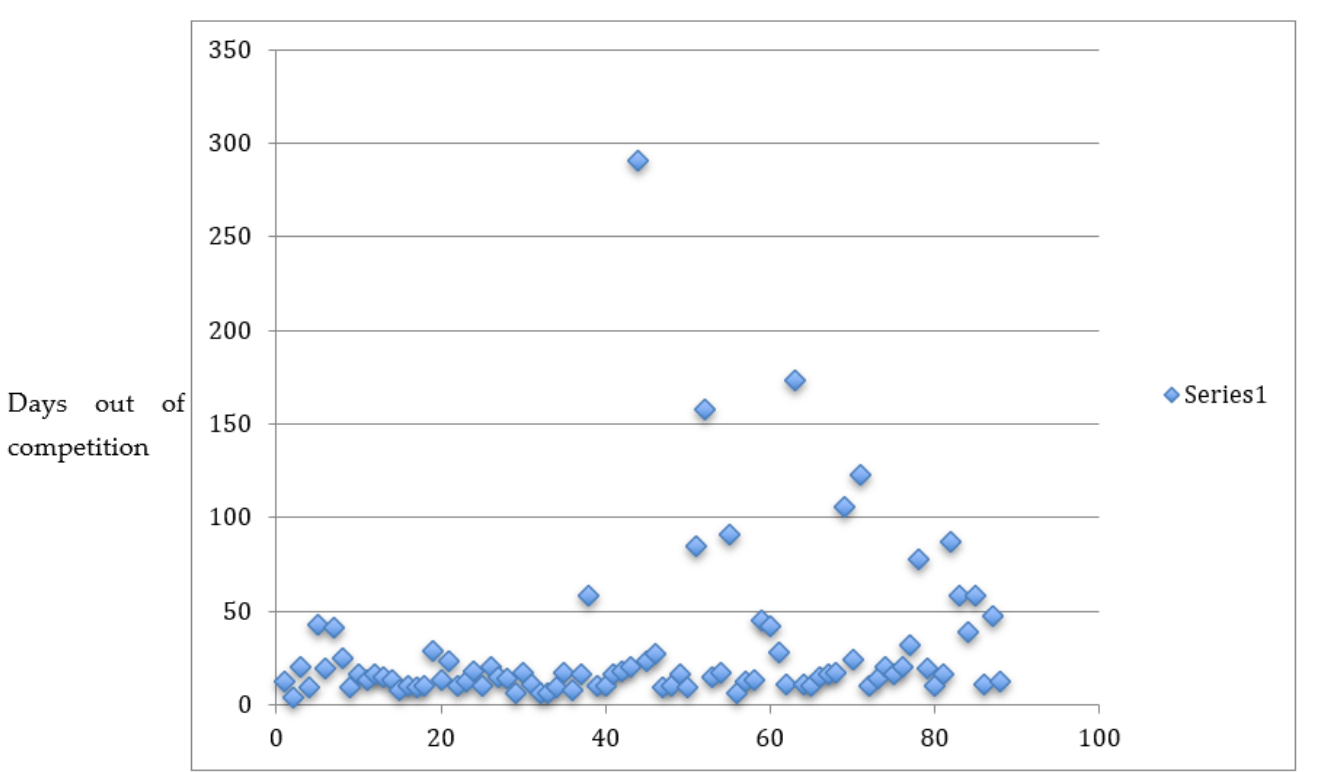
Figure 1. The number of concussions and the days out of competition for each Figure 1 . The number of concussions and the days out of competition for each concussion.